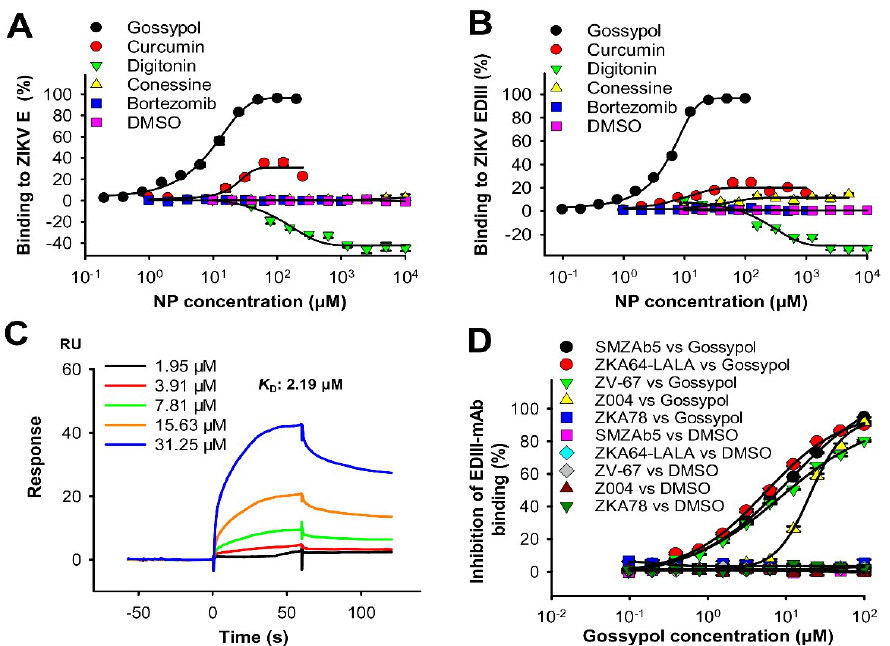
Figure 4. Characterization of natural products in binding to ZIKV E protein and inhibition of binding of ZIKV envelope protein domain III (EDIII)-specific mAb to EDIII. Binding of natural products (NPs) to ZIKV full-length E ( A ) or EDIII ( B ) proteins, as detected by ELISA. The percent binding was reported in the presence or absence of serially diluted NPs using the formula ((1—(E / EDIII-NP) / (E / EDIII)) × 100) for E / EDIII binding. The 50% e ff ective concentration (EC 50 ) values were calculated. The data are expressed as mean ± s.e.m. ( n = 4). ( C ) Surface plasmon resonance (SPR) analysis of binding between gossypol and ZIKV E. Binding a ffi nity ( K D : equilibrium dissociation constant) is shown. ( D ) The ability of gossypol to inhibit the binding between ZIKV EDIII and EDIII-specific neutralizing mAbs. The concentrations of ZIKV EDIII and mAbs were 1.5 and 0.5 µ g / mL, respectively. The percent inhibition in the EDIII-mAb binding was measured in the presence or absence of serially diluted gossypol using the formula ((1-(EDIII-mAb-gossypol) / (EDIII-mAb) × 100), which, in turn, formed the basis for calculating 50% inhibitory concentration (IC 50 ) values. ZIKV EDI / DII-specific mAb (ZKA78) and DMSO were used as controls. The data are expressed as mean ± s.e.m. ( n = 4). The experiments were repeated twice, with similar